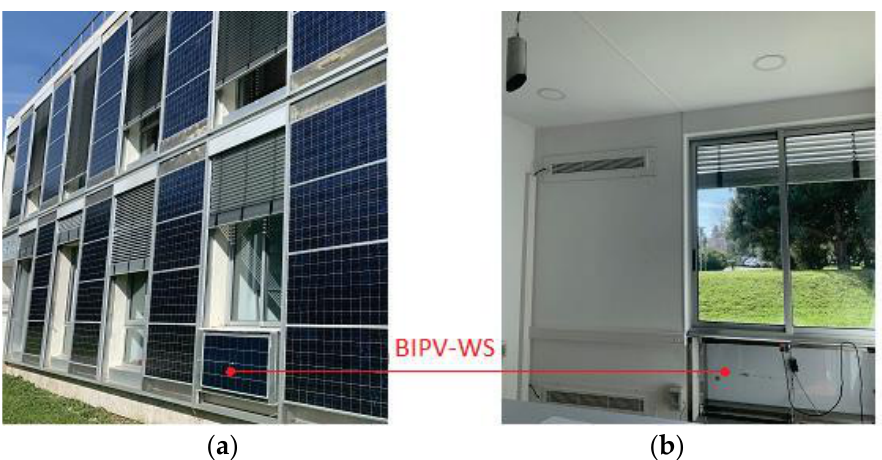
Figure 2. Prototype integrated in the façade [15]: ( a ) outside view; ( b ) inside view—test room.